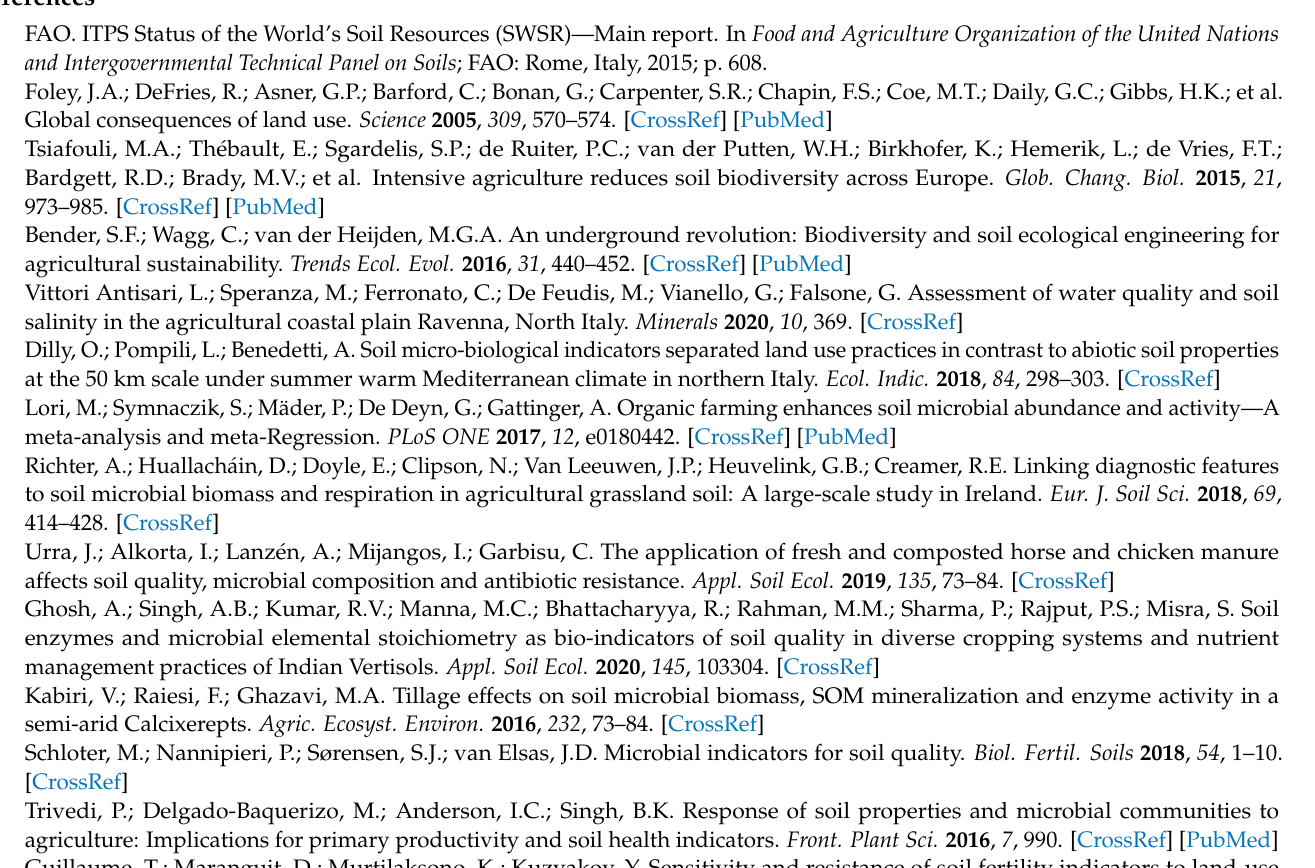
Table S2: The scores of indicators for BFI calculation, Table S3: Results of Kruskal–Wallis test on the nutrients content in rhizospere (Rhizo) and tomato organs (Roots, Old and Young leaves, Stem, Fruit) in processing tomato fields located in Modena (MO), Ferrara (MEZ) and Ravenna (RA) provinces, Emilia Romagna Region,